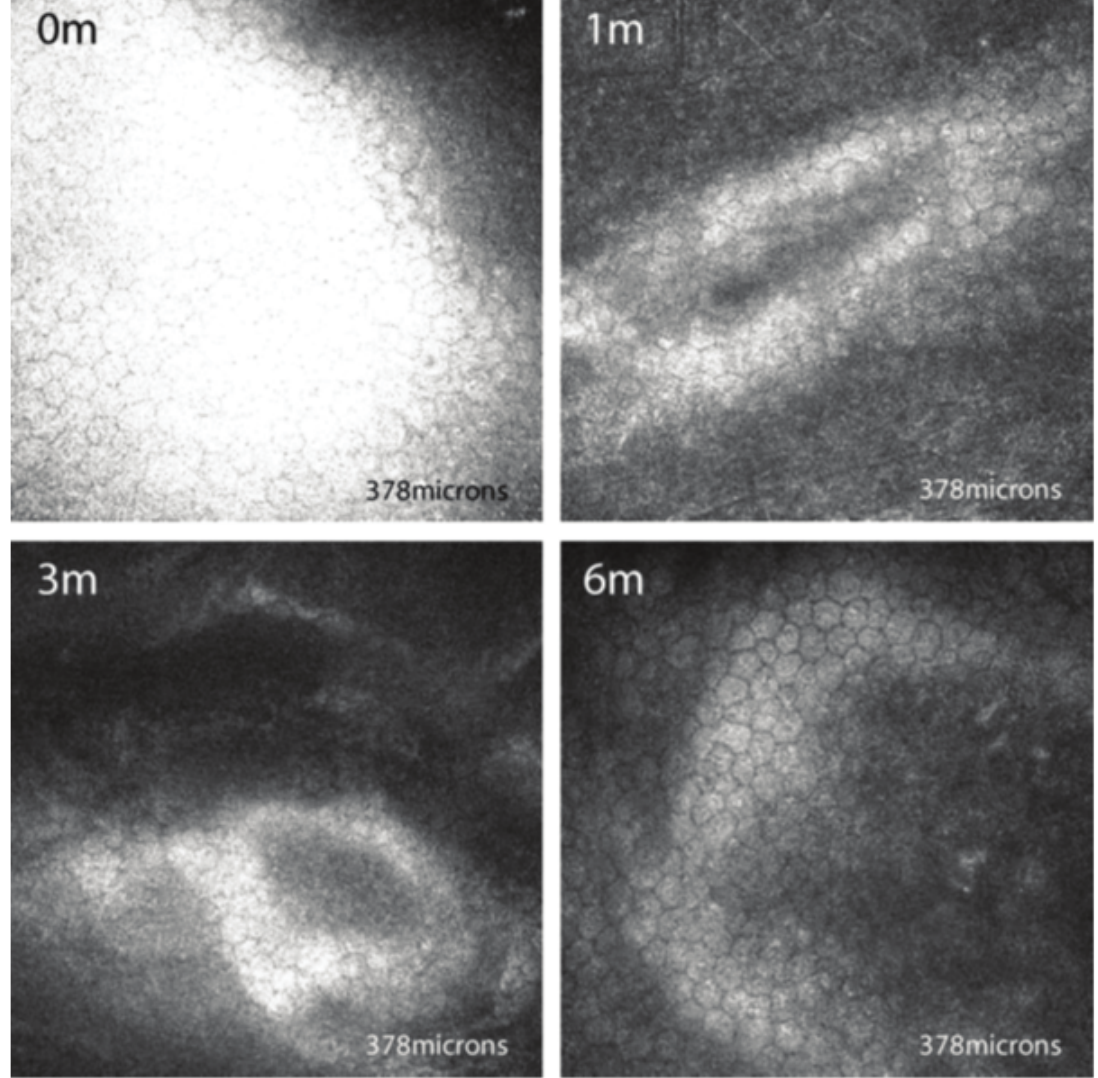
Figure 6. In vivo confocal microscopic images of the endothelium of a representative patient, taken at the same level at each visit. The endothelial morphology and density appeared normal preoperatively (0 m) and at one-, three-, and six-month visits (0 m, 3 m, and 6 m,